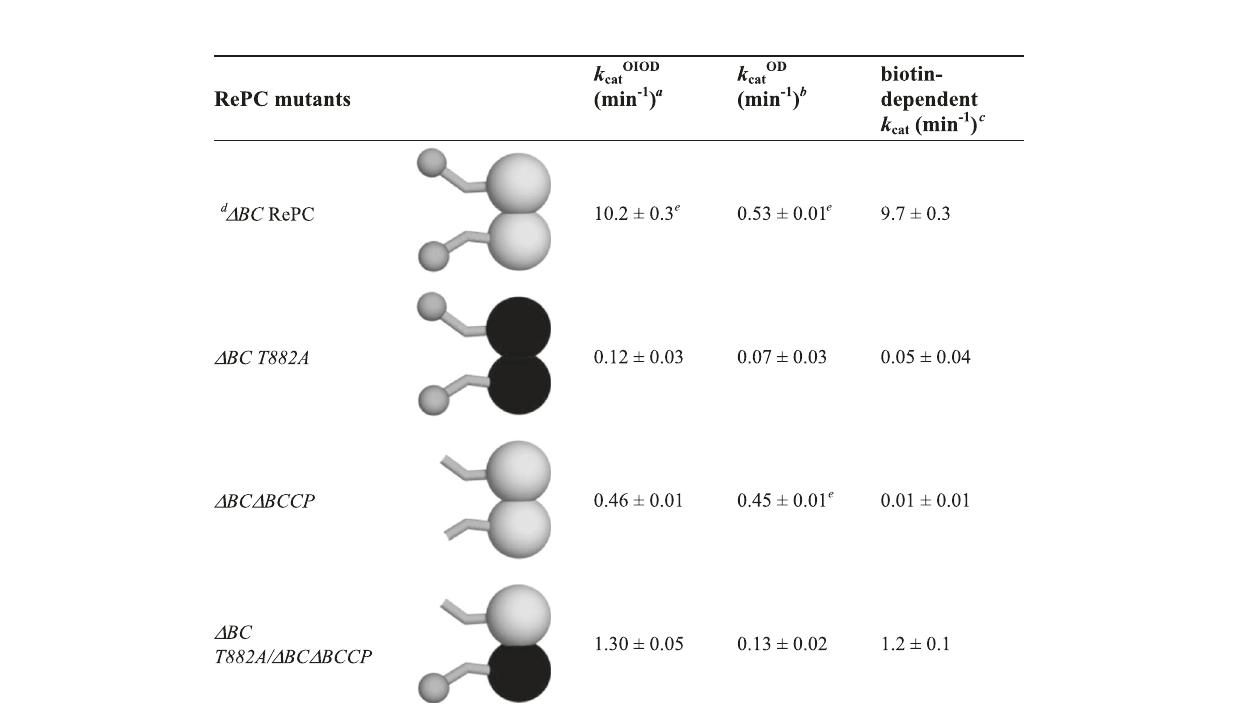
Table 1 Oxaloacetate decarboxylation catalyzed by Δ BC dimers of